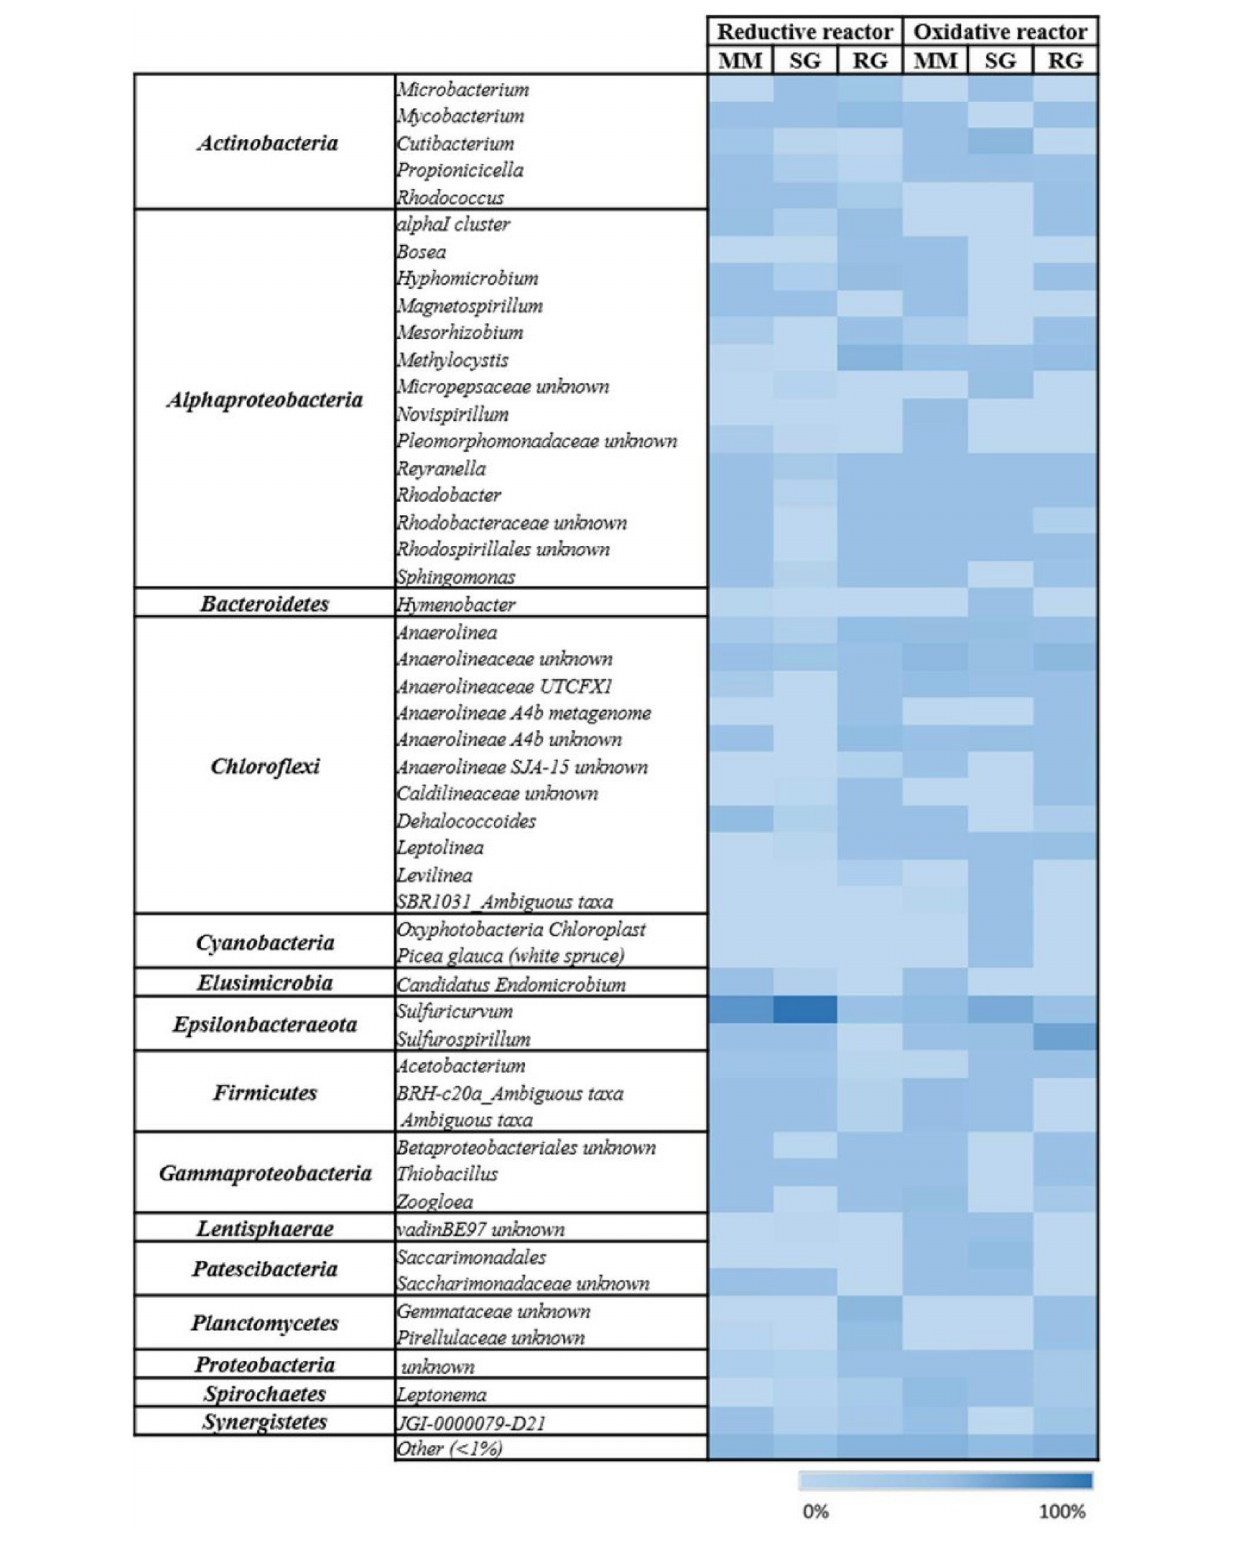
Frontiers in Microbiology |